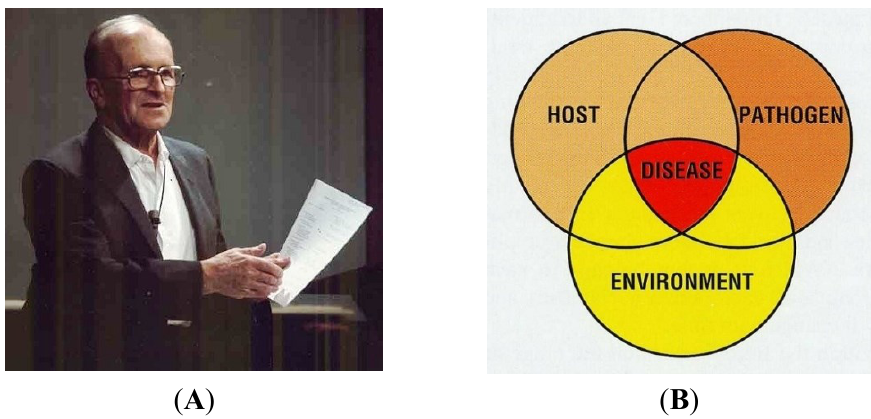
Figure 6. ( A ) Stanisław F. Snieszko (1902–1984) received his Ph.D. degree in